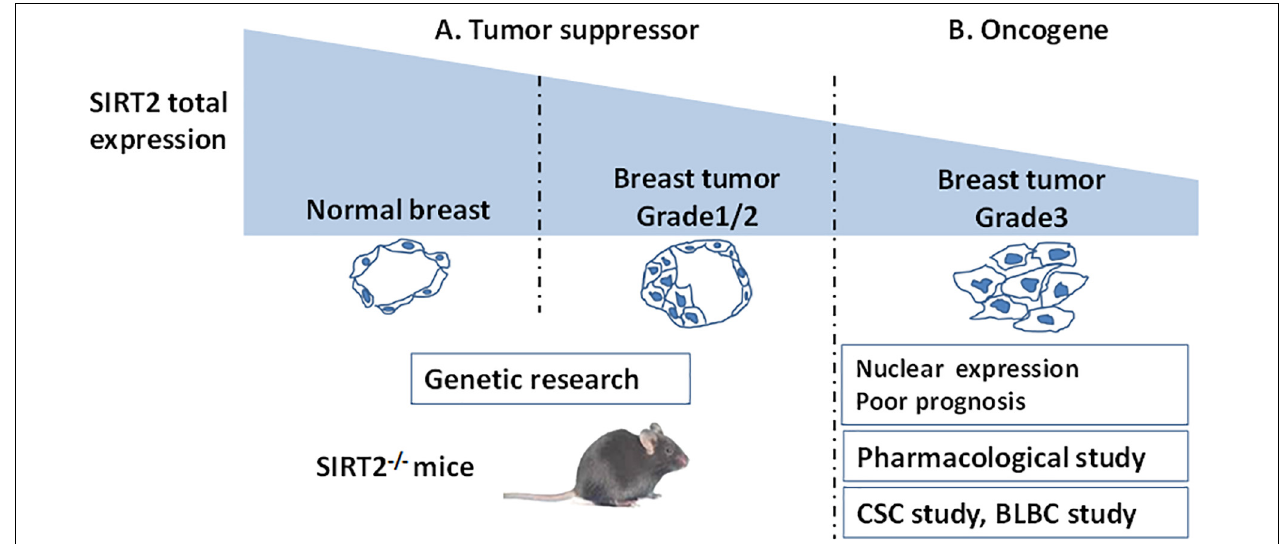
FIGURE 2 | A schema shows SIRT2’s functions evaluated by different breast cancer studies. (A) SIRT2 is highly expressed in the normal breast compared with breast tumor. This clinical result suggest that SIRT2 might act as a tumor suppressor, which is supported by Genetic research (SIRT2 Knockout). (B) However, in Grade 3 breast cancer, high levels of nuclear SIRT2 are associated with poor clinical outcome, indicating that SIRT2 might act as an oncogene in more aggressive malignancies. The studies on CSC and BLBC support this inference. Pharmacological research of SIRT2 specific inhibitor also finds the oncogenic role of SIRT2.